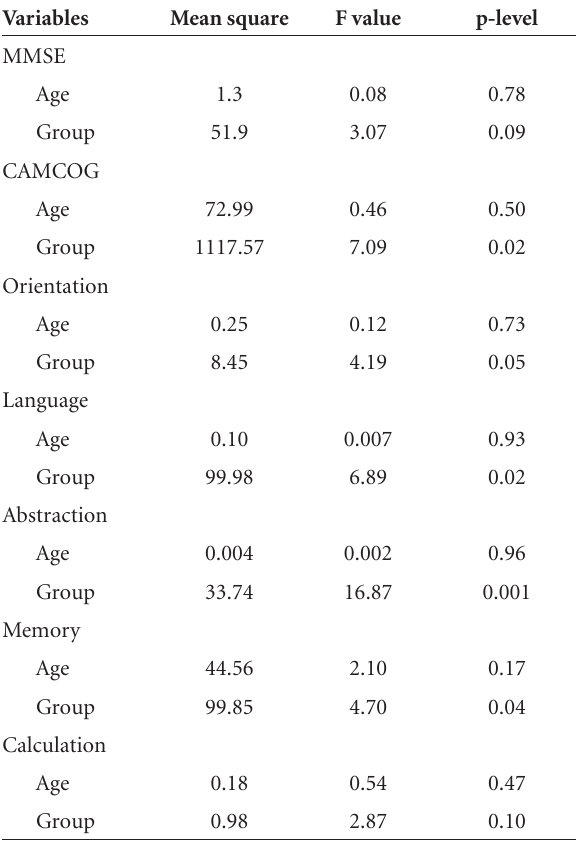
Table 2. Final model of multiple logistic regressions best ex- plaining association between lower score on cognitive tests and